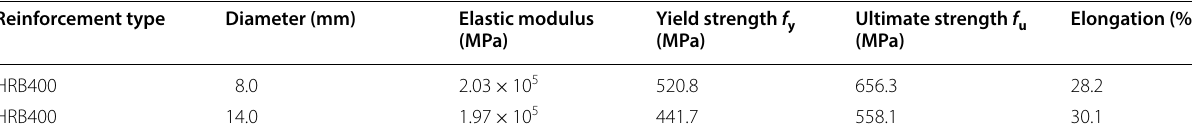
Table 2 The measured mechanical properties of the steel